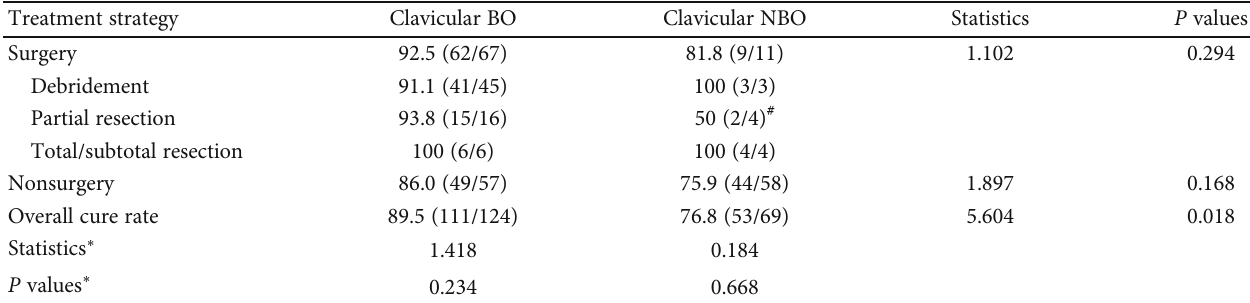
Table 3: Treatment strategy and e ffi cacy between clavicular BO and